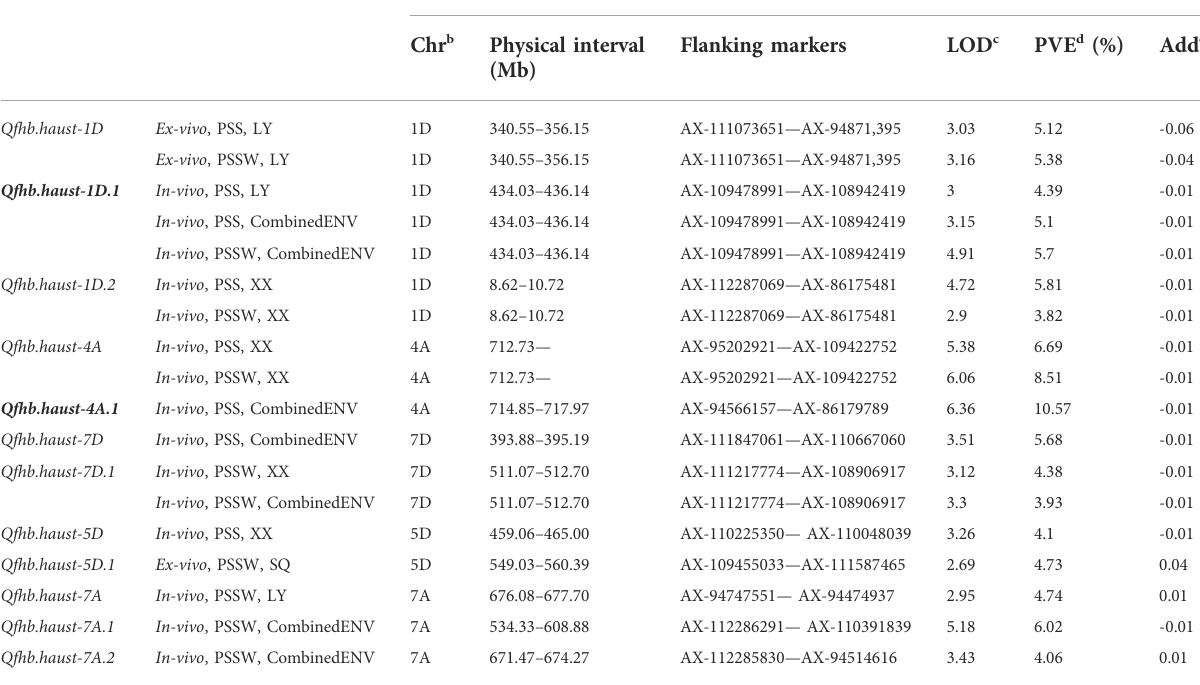
TABLE 4 Quantitative trait loci (QTL) detected in more than two environments for Fusarium head blight resistance mapped in the ZM 578/JM 22 population assessed by PSS and PSSW. QTL Trait, Environment a